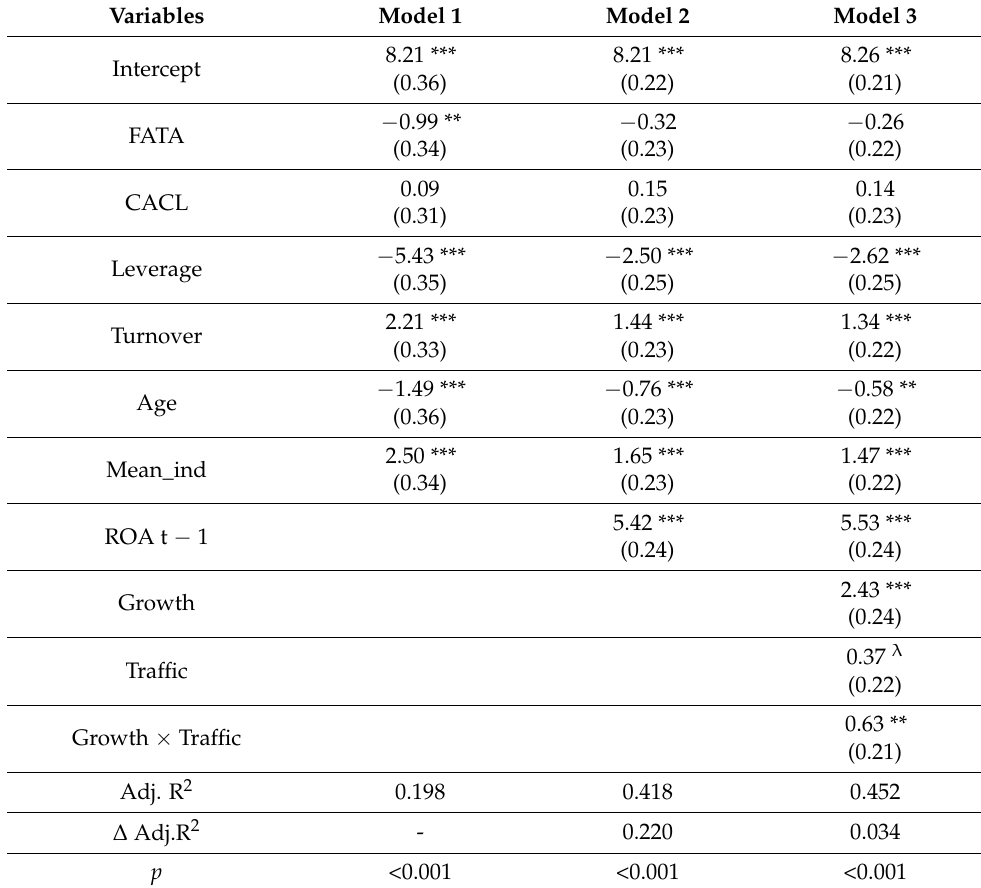
Table 3. Regression results (training sample, dependent variable—ROA, standard errors are shown in parentheses).